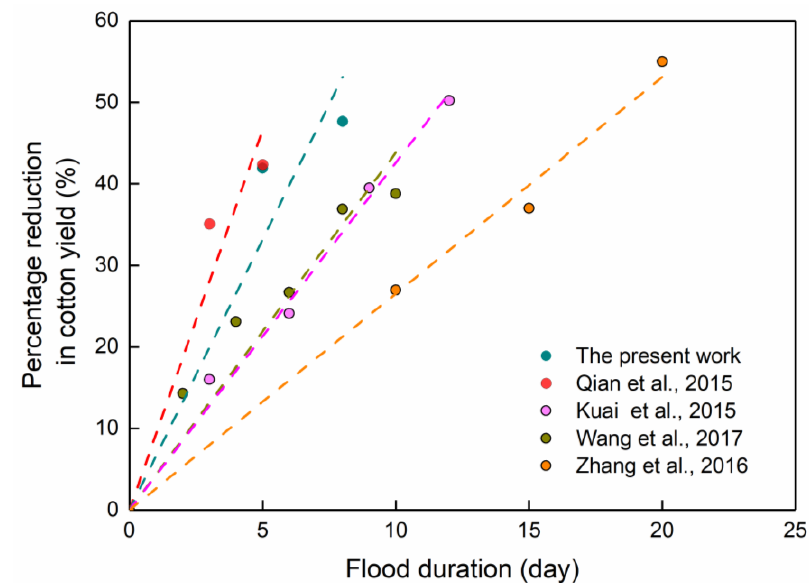
Figure 6. Comparisons of the yield-reducing rates of flood in recent cotton flood experiments. All of these experiments were carried out at the flowering stage and had unaltered and shallow flood depths during flood periods. The displayed colored lines are linear regressions to determine the yield-reducing rates (i.e., the k in Equation (4)), and their calculated k values are 6.22, 9.93, 4.26, 4.39, and 2.26 for the present work and the literatures [26,27,31,35], respectively.